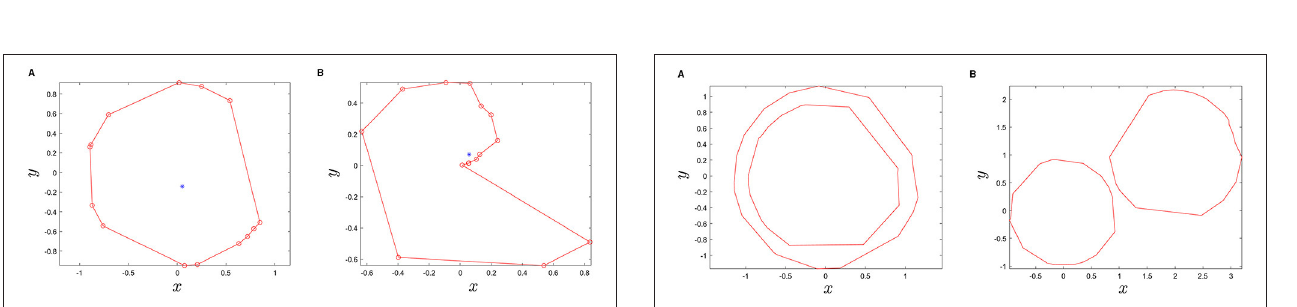
FIGURE 5 | Two example contour lines. Red circle markers are points of each FIGURE 6 | Illustration showing instances when two given contour lines are contour line and the blue dots indicate the center point of polygons (A) either (A) enclosed or (B) not enclosed using the MATLAB built-in function g circle 0.7606, area 2.3821 and (B) g circle 0.0566, and area 0.9515. = = = =